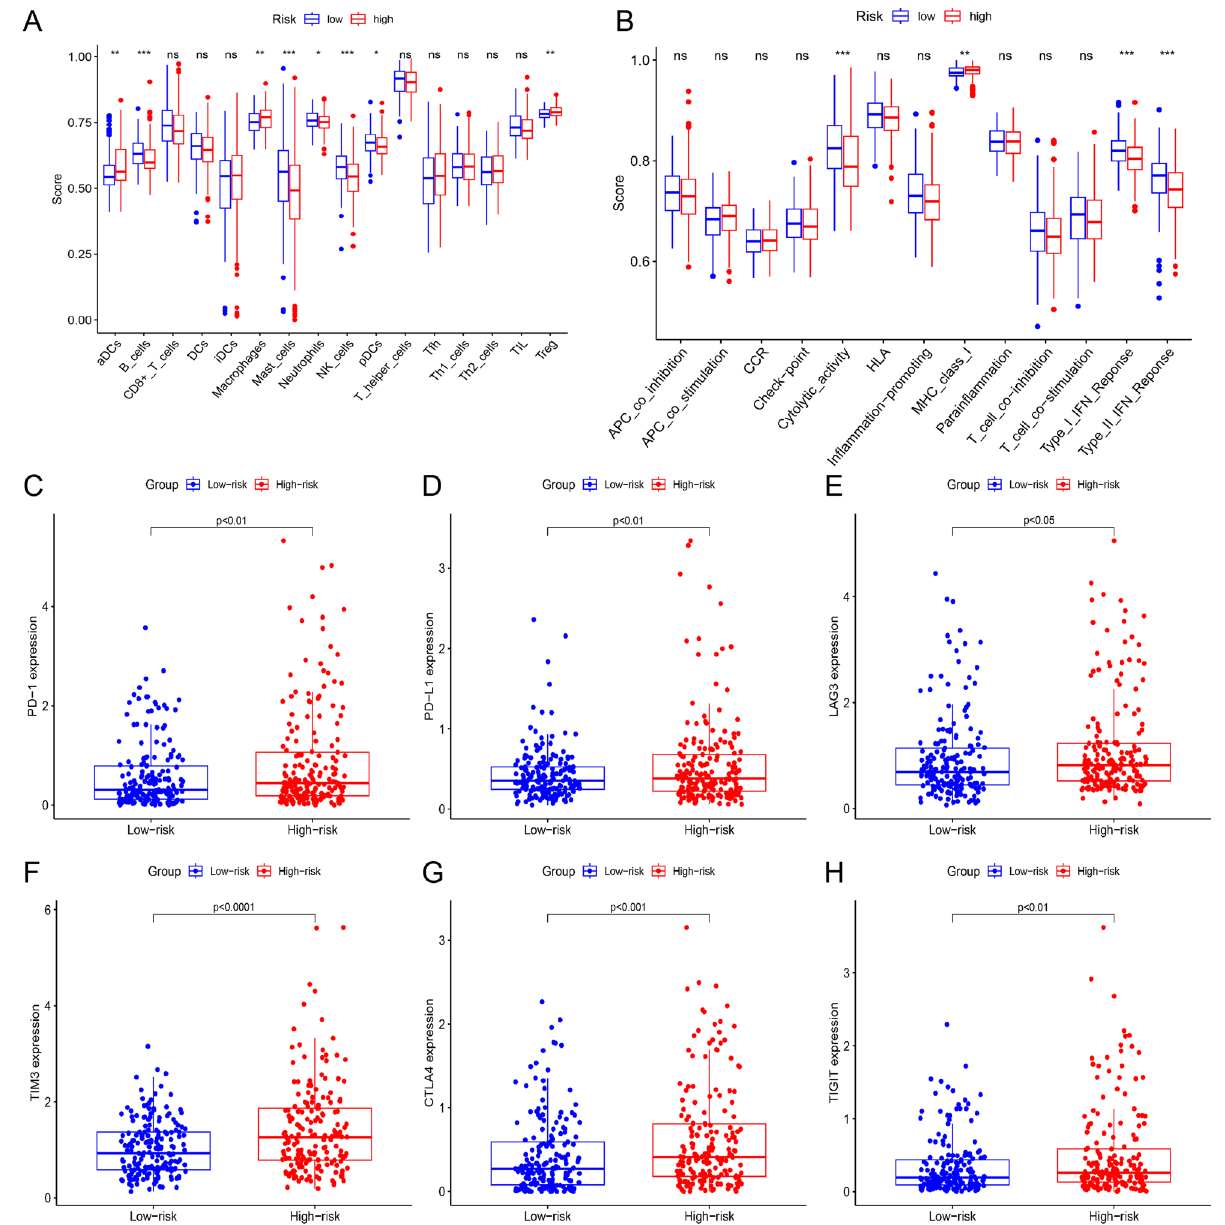
Figure 7. Risk score-related immune status. ( A , B ) Results of ssGSEA. ( C – H ) immune checkpoint expression based on risk grouping. *P < 0.05, ** P < 0.01, *** P < 0.001, ns, not